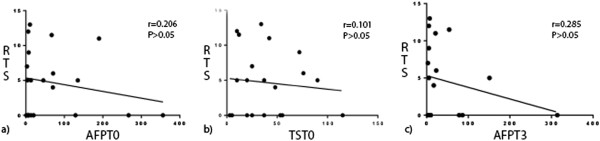
Correlations between studied variables and recurrent tumor size in patients who underwent HR. (a) Pre-treatment serum AFP level (AFPT0) and recurrent tumor size (RTS) were not correlated (r = 0.206, P > 0.05). (b) Recurrent tumor size (TST0) and RTS were not correlated (r = 0.101, P > 0.05). (c) The 3-month post-treatment serum level (AFTT3) and RTS were not correlated (r = 0.251, P > 0.05).